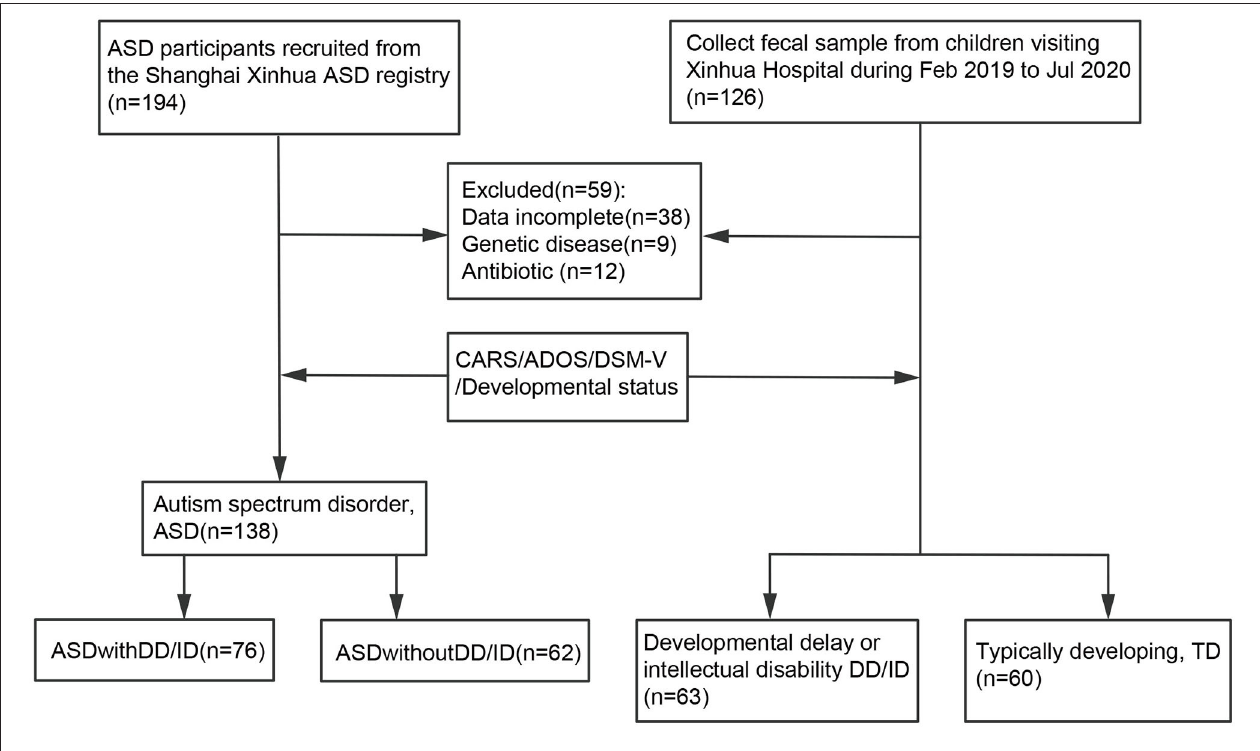
FIGURE 1 | Flowchart of the study design.